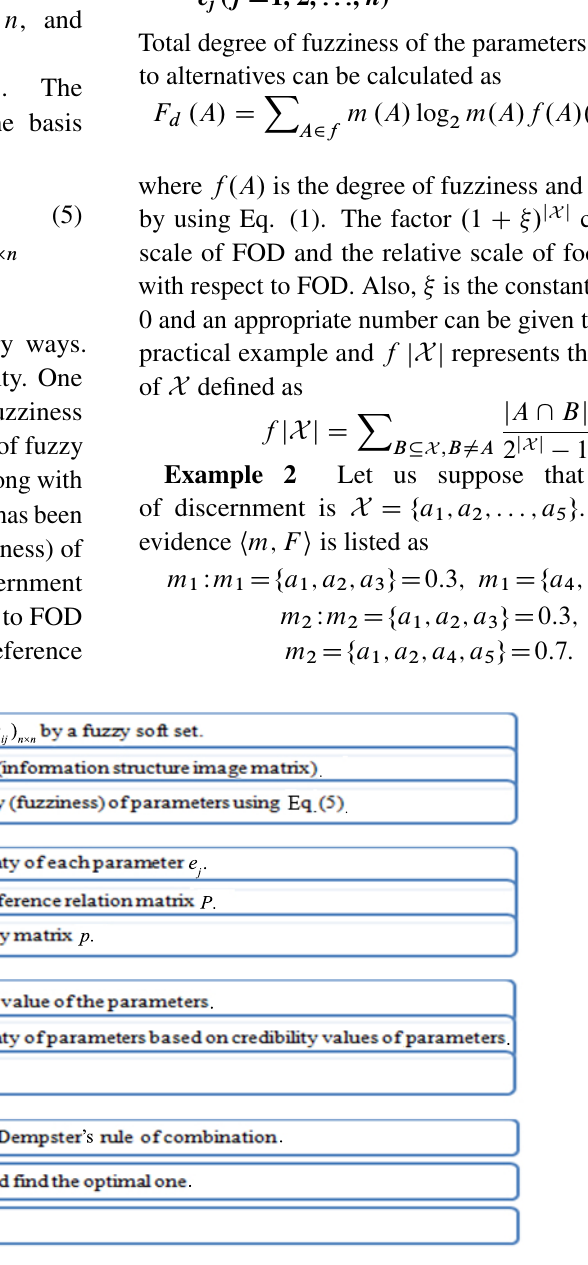
Fig. 1 Flowchart of our proposed